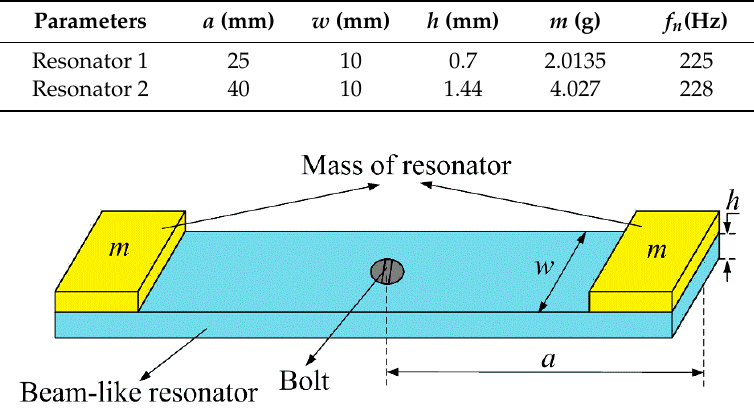
Figure 7. Schematic diagram of the designed beam-like uncoupled force-moment type resonator.